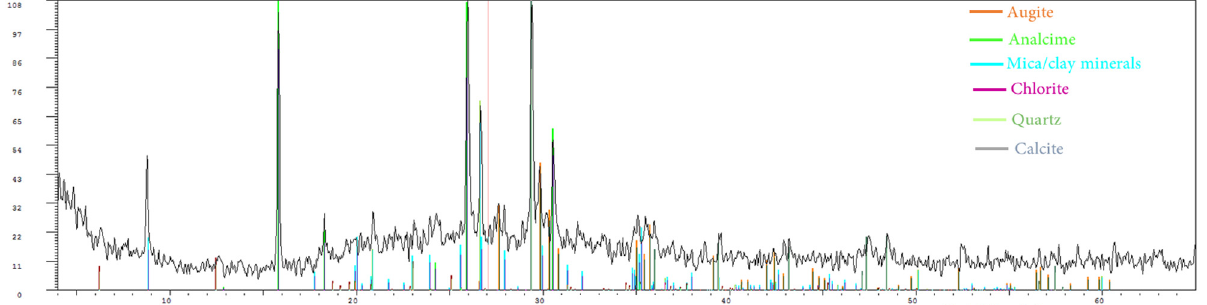
Figure 12. Mineralogical composition of M4 sample representative pozzolanic mortars.